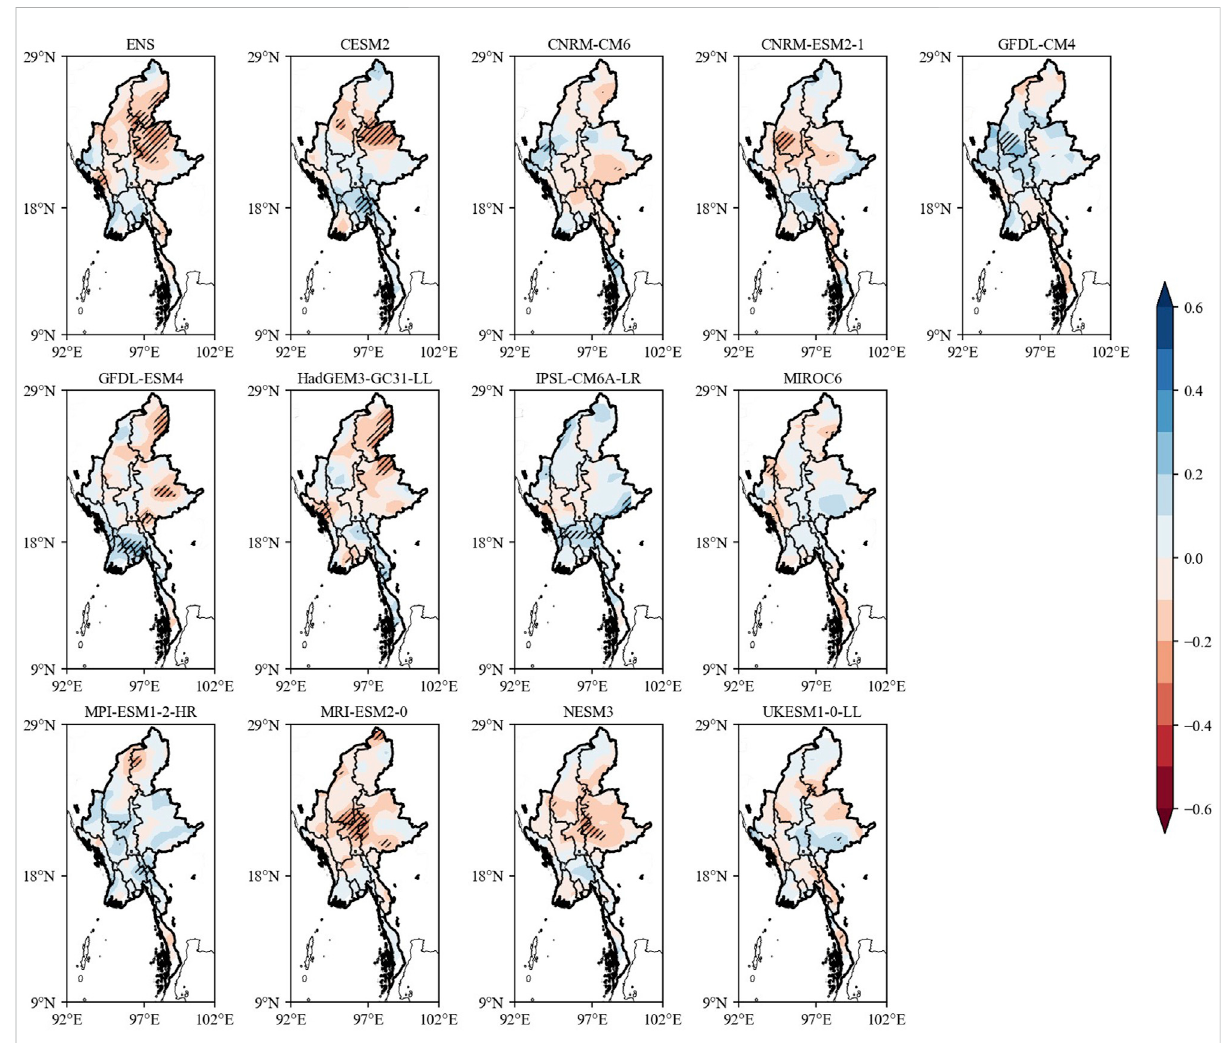
FIGURE 8 Spatial distribution of correlation coef fi cient of annual GPCC PRE with the 12 CMIP6 models. Hatches indicate signi fi cance at the 90% con fi dence level.)